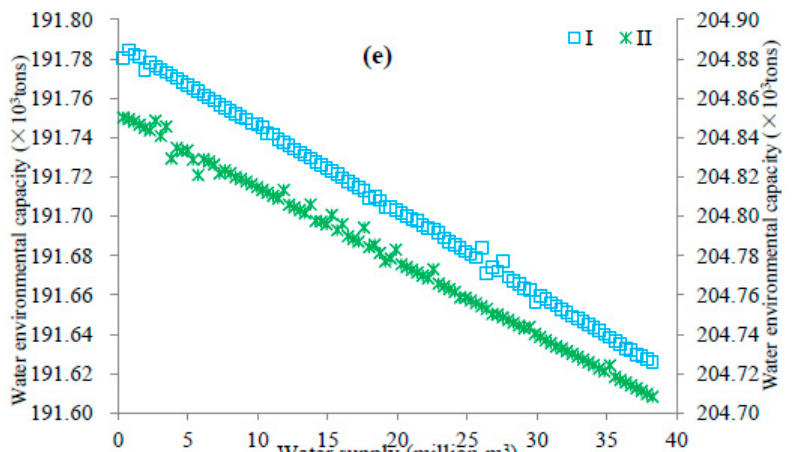
Figure 6. Supply-water environmental capacity nexus responded to the downstream boundary scenarios: “I” is the result of the figure 5with original downstream boundary condition corresponding to the left Y axes while “II” represents the water levels increased by 0.5m corresponding to the right Y axes. ( a ) Stationary, ( b )